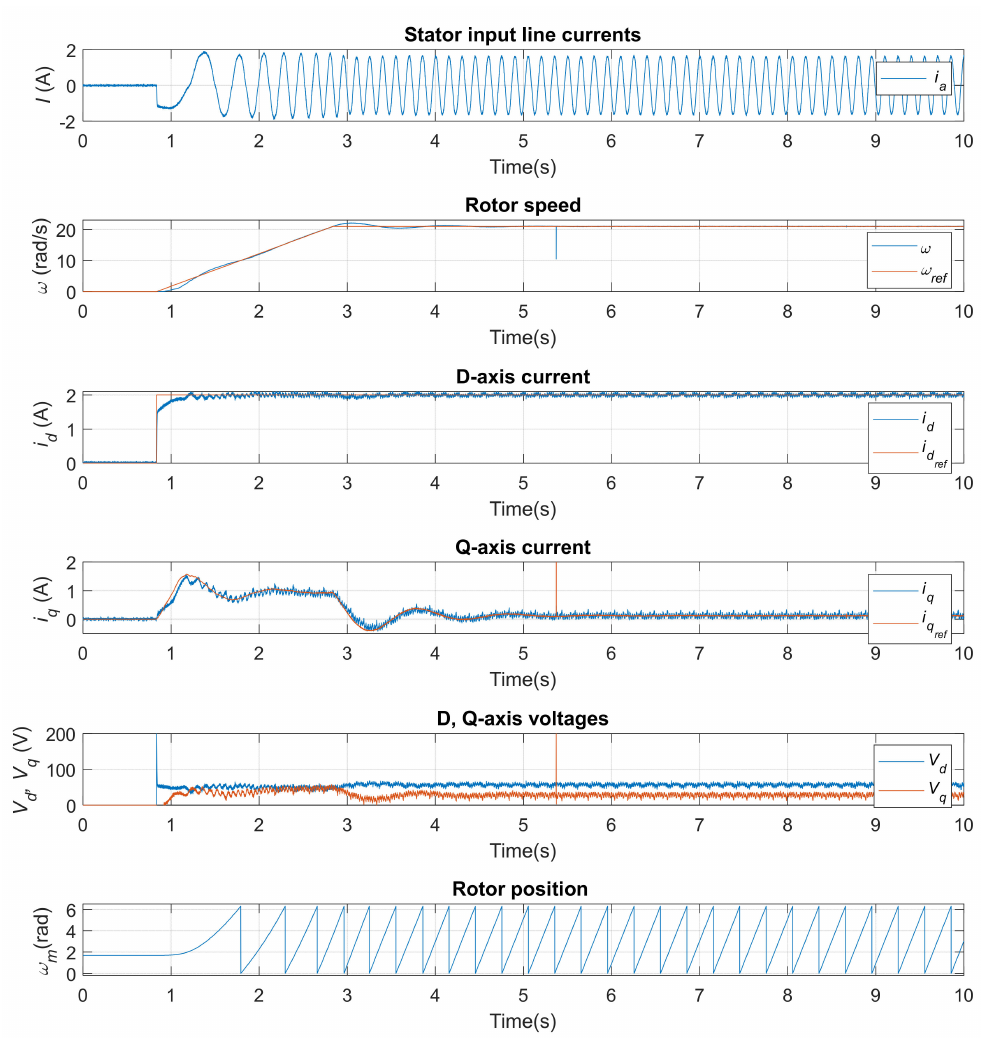
Figure 15. Startup ramp response of FOC of SynRM; I a : the measured phase a current, ω : the measures speed ( ω ) and the reference speed ( ω ref ), i d : the direct axis current ( i d ) and the direct axis current reference ( i dref ), i q : the quadrature axis current ( i q ) and the quadrature axis current reference ( i qref ), V dq : the direct and quadrature axis voltages, θ m : the mechanical angle of the